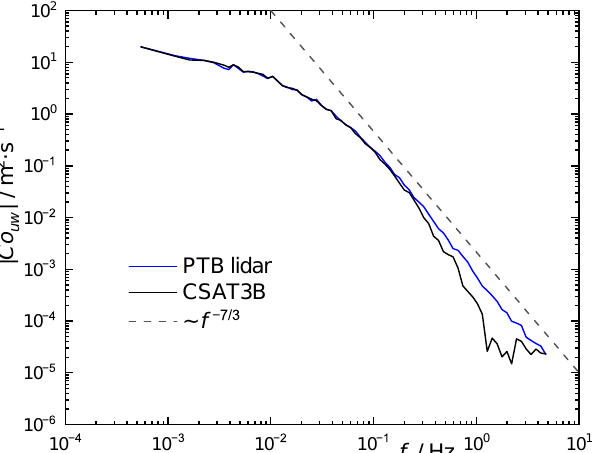
Figure 12. Results of the 2019 comparative measurement between the PTB bistatic lidar and a CSAT3B ultrasonic anemometer mounted on top of a 30 m mast in turbulent flow, showing the ensemble cospectra Co uw between the wind velocity components u and w (absolute values) of the PTB bistatic lidar and the CSAT3B sonic anemometer. The dashed line indicates the theoretical − 7/3 power law in the inertial